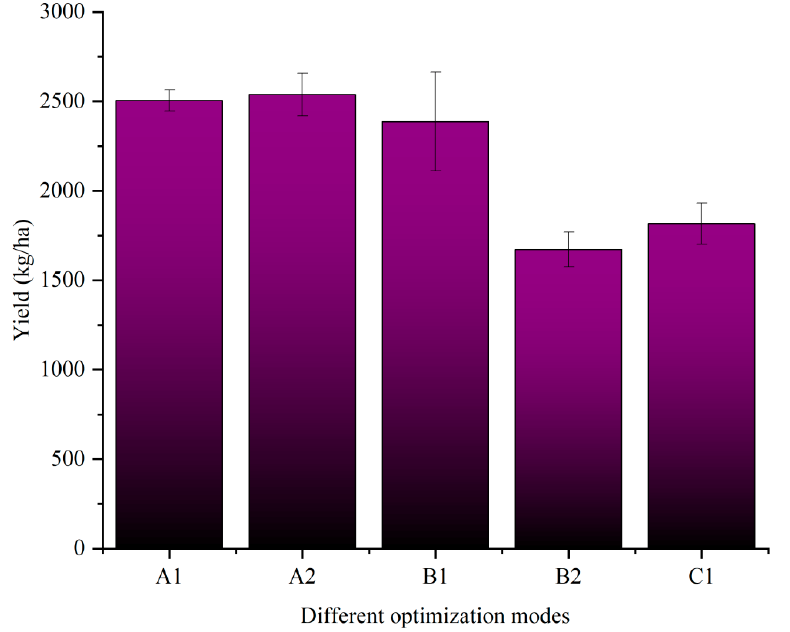
Figure 4. Crop yield in the different optimization models. Table 3. Correlation coefficients between soil properties and crop